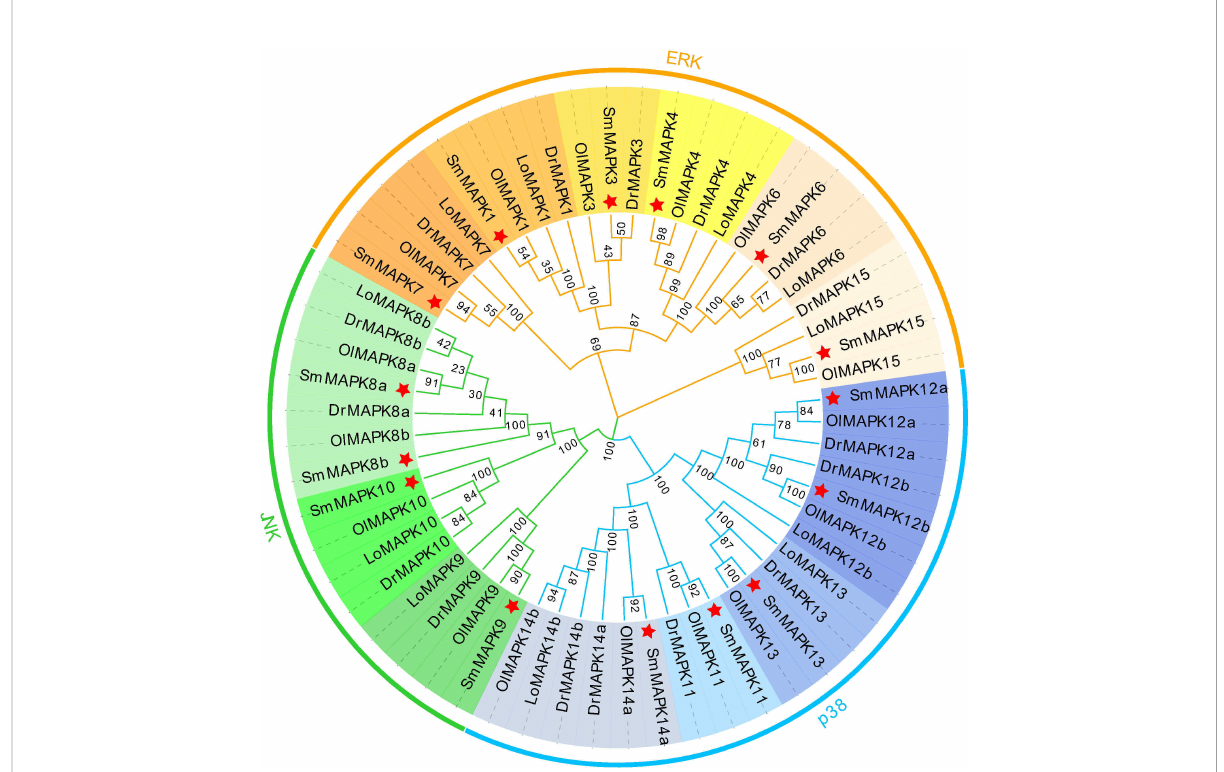
FIGURE 1 Phylogenetic analysis of mitogen-activated protein kinases (MAPKs) in diverse teleost species. A total of 58 MAPK protein sequences from four teleost species were used to create the neighbor-joining (NJ) tree using MEGA 11.0 with the JTT model and 1,000 bootstrap replications. Three subfamilies are labeled extracellular signal-regulated kinase (ERK), c-Jun NH 2 -terminal kinase (JNK), and p38. Thirteen clades are discriminated by different colors, and the MAPKs of Scophthalmus maximus are marked with a red asterisk. Dr, Danio rerio ; Ol, Oryzias latipes ; and Lo, Lepisosteus oculatus